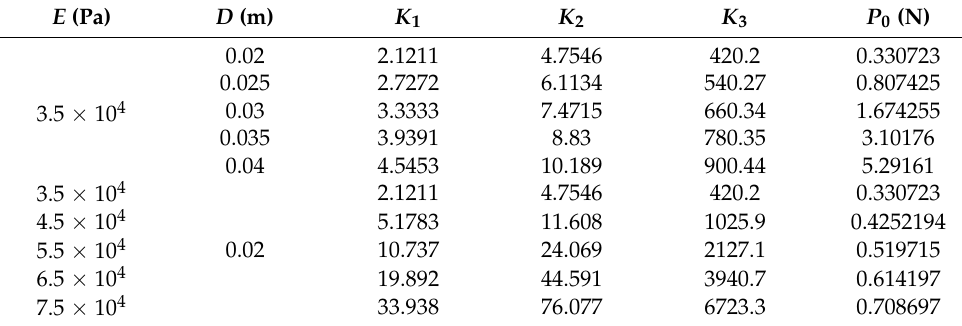
Figure 8. Passive vibration isolation model. The kinetic differential equation of the SGC vibration isolation system can be written as